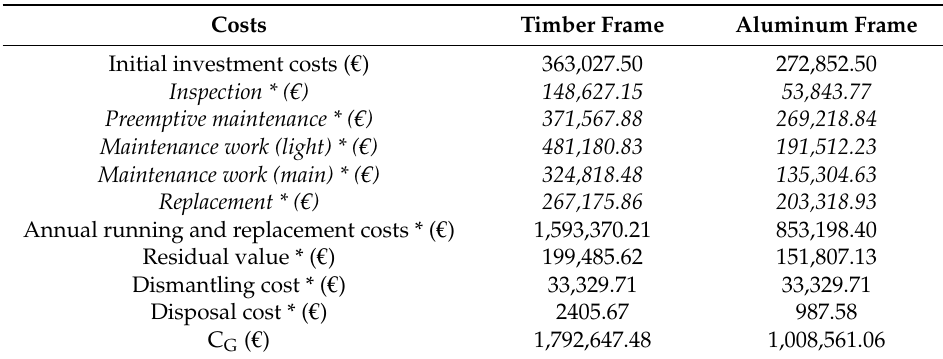
Table 9. Summary of the value of economic indicators.